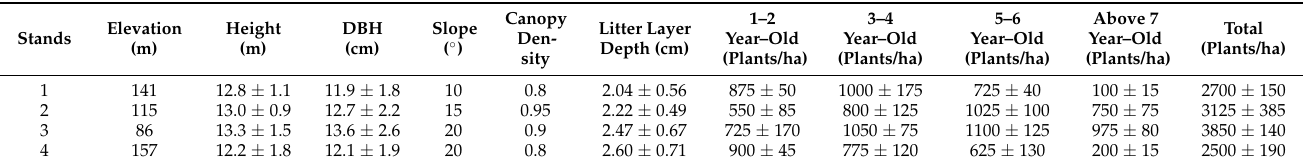
Table 1. General information of the study moso bamboo stands (mean ± SD, n =